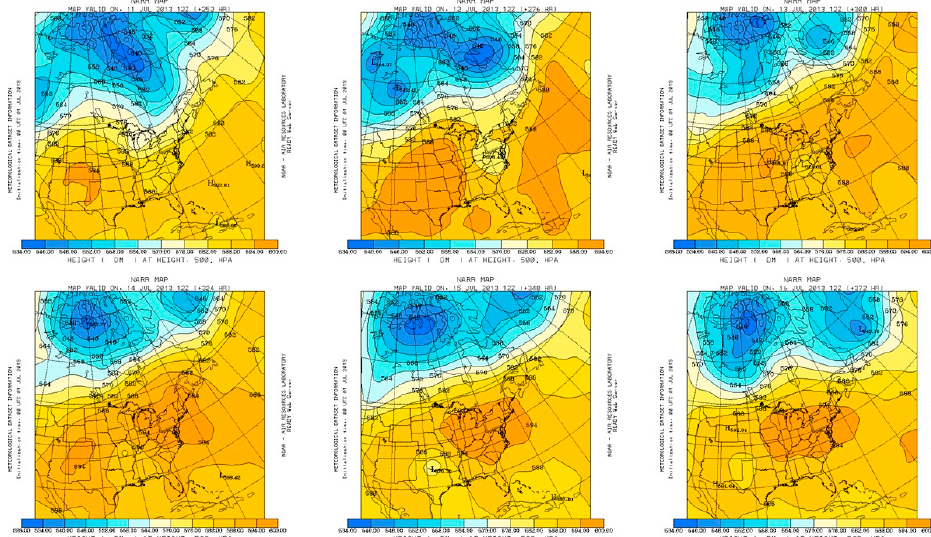
Figure 16. 500 hPa GPH pattern, 11 July (upper left) to 16 July (lower right), 2013. Credit: NOAA ARL. At the surface, a high pressure ridge spread westward from the Atlantic coast to the Great Lakes region during 14–15 July and then diminished in strength and eventually moved eastward from